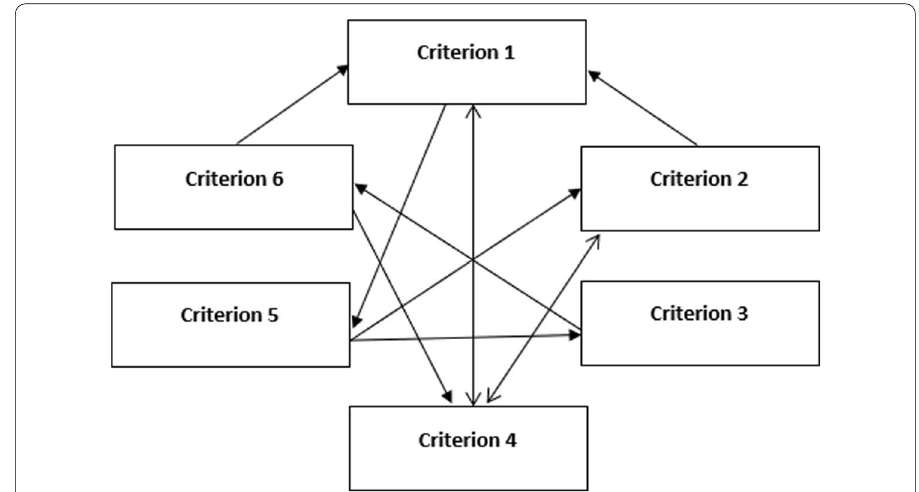
Fig. 2 Impact–relation map for the criteria